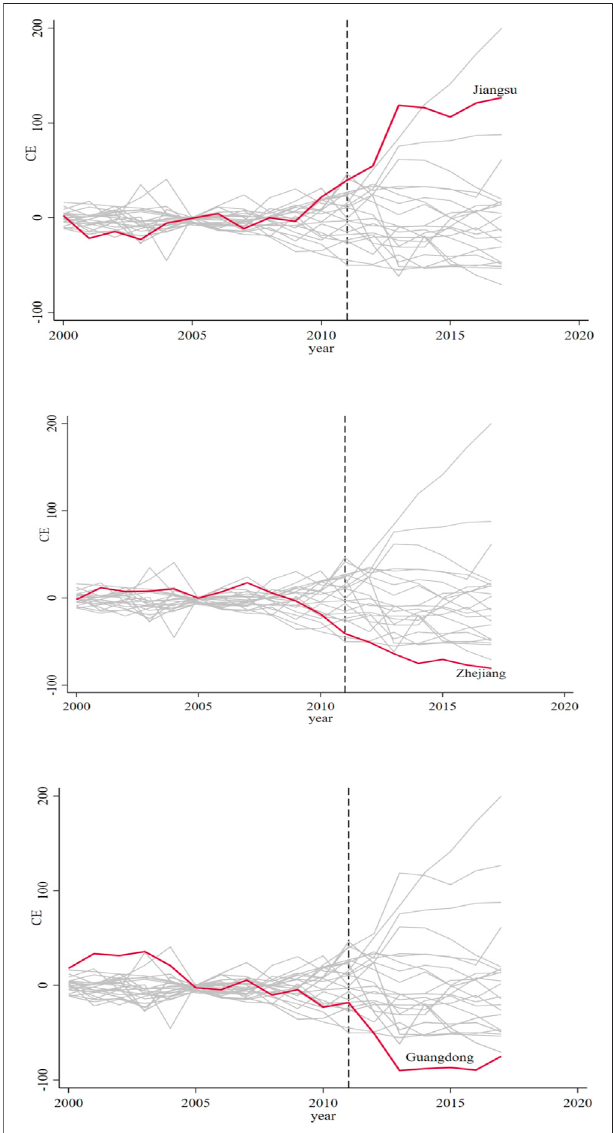
FIGURE 2 | Shock effects of experimental provinces and other regions (from top to bottom: Guangdong, Jiangsu, Zhejiang).